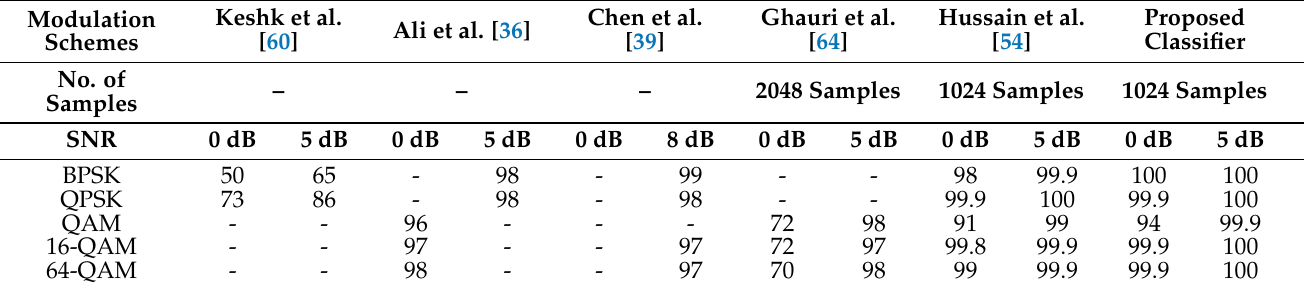
Table 6. PRA comparison on the AWGN channel